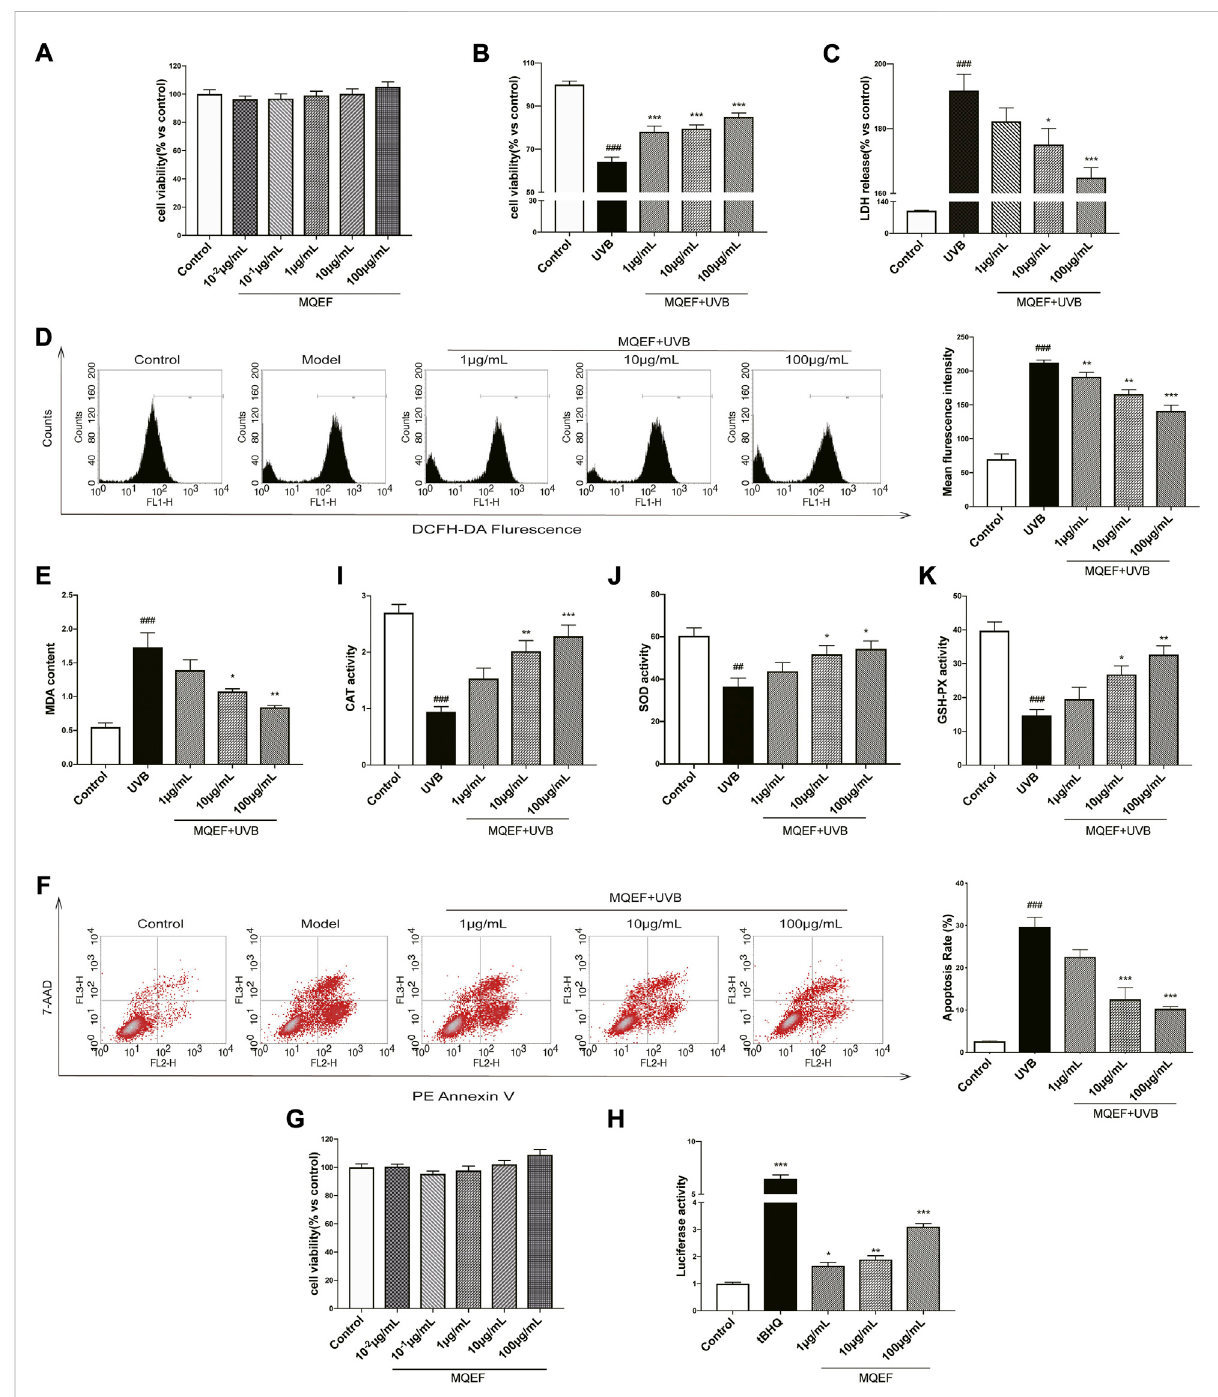
FIGURE 2 Modi fi edQing ’ eFormula(MQEF)protectsHaCaTcellsfromUV-Inducedoxidativedamage.CellswerepretreatedwithMQEFatdosesof10 − 2 ,10 − 1 ,1,10, and100 μ g/mlaswellasnocompoundtreatmentfor 24 handthenirradiatedwithUVBatadoseof60 mJ/cm 2 .Afterirradiation,cellswerecontinuedto be culturedfor24 handthenprocessedforsubsequentanalysis. (A) EffectofMQEFtreatmentfor24 honthecytotoxicityofHaCaTcells. (B) EffectofMQEFon HaCaT cell viability after UVB irradiation. (C) Effect of MQEF on lactate dehydrogenase (LDH) release of HaCaT cells after UVB irradiation to evaluate the degree of cell membrane damage. (D) Effects of MQEFonreactiveoxygen species (ROS)content in HaCaTcellsafter UVBirradiation. (E) Effectsof MQEFon malondialdehyde (MDA) content in HaCaT cells after UVB irradiation. (F – H) Effects of MQEF on catalase (CAT), superoxide dismutase (SOD) and glutathione peroxidase (GSH-Px) activity in HaCaT cells after UVB irradiation. (I) Effects of MQEF on apoptosis in HaCaT cells after UVB irradiation. (J) Effect of MQEF treatment for 24 h on cytotoxicity of HEK293T cells. (K) Effects of MQEF on ARE transcriptional activity of HEK293T cells. Data are mean ± SEM from 3independentexperiments. ### p < 0.001comparedwiththecontrolgroup, ## p < 0.01comparedwiththecontrolgroup; # p < 0.05comparedwiththecontrol group; *** p < 0.001 compared with the model group; ** p < 0.01 compared with the model group; * p < 0.05 compared with the model